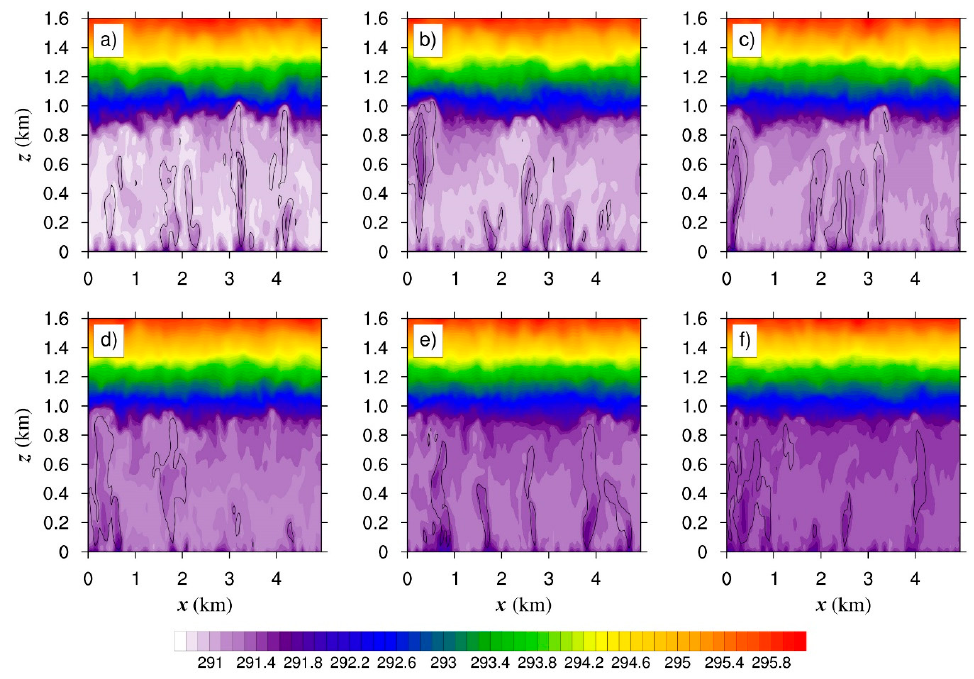
Figure 5. X – z cross-sections of the potential temperature averaged over 200 time-steps (about 6–7 min) for the cases of ( a ) CTL, AOD = 0; ( b ) A03, AOD = 0.3; ( c ) A06, AOD = 0.6; ( d ) A09, AOD = 0.9; ( e ) A12, AOD = 1.2; and ( f ) A15, AOD = 1.5 with the free-atmosphere potential temperature gradient of 6 K km − 1 . The black lines represent contour lines of positive vertical velocity, as shown in Figure